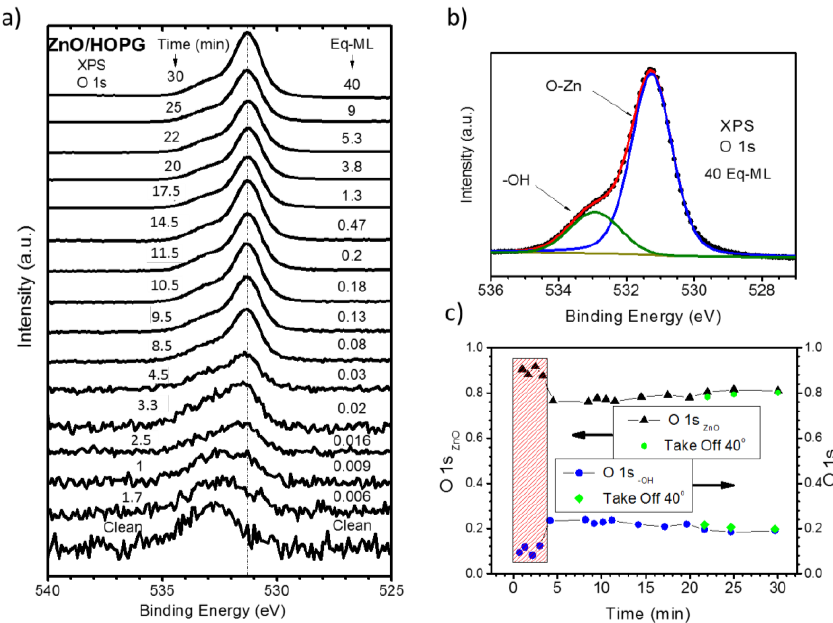
Figure 2. ( a ) XPS O 1 s spectra as a function of the coverage and deposition time for the growth of ZnO on HOPG. ( b ) XPS O 1 s fitting of ZnO on HOPG after 30 min of deposition; ( c ) relative intensities of O–Zn and defects/OH components as a function of the deposition time.